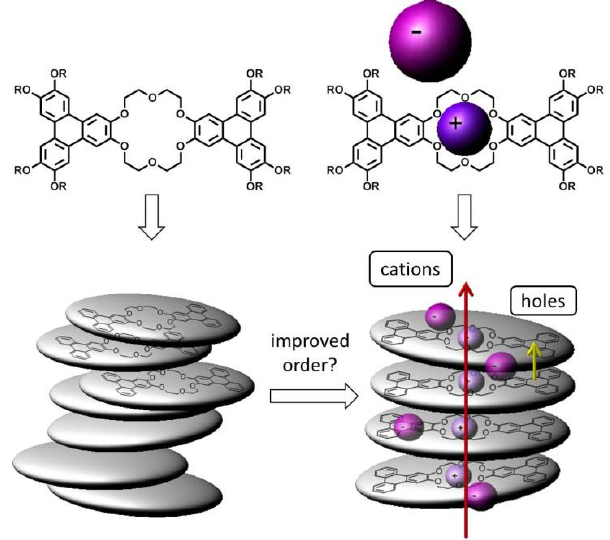
Figure 1. Structures of the bi-centred crown ether based discotic mesogens in this study and the expected impact of salt complexation. The coordinated ions are expected to improve the order and thus the hole transport via the stacked triphenylenes. Furthermore, the mesophase should provide channels for fast cation transport along the columns due to the stacked crown ether moieties.